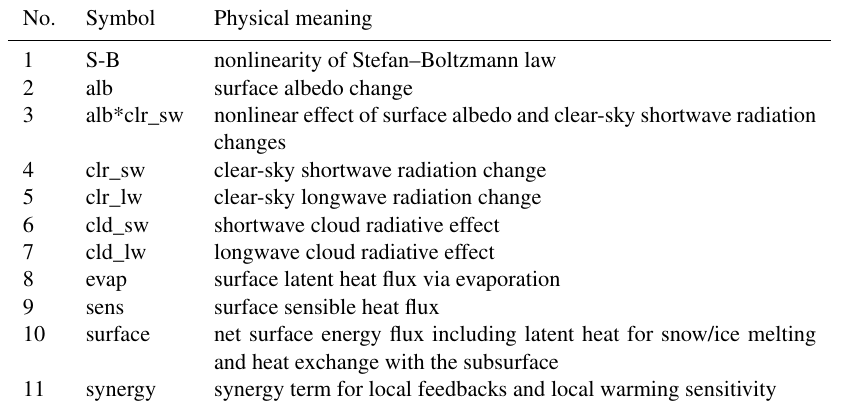
Table 3. A list of the energy flux terms used in Figs. 5 and 12. Row no. 1 represents the strength of the global mean feedback calculated with local warming sensitivity. Row nos. 2–10 represent the strength of local feedback calculated with global mean warming sensitivity.